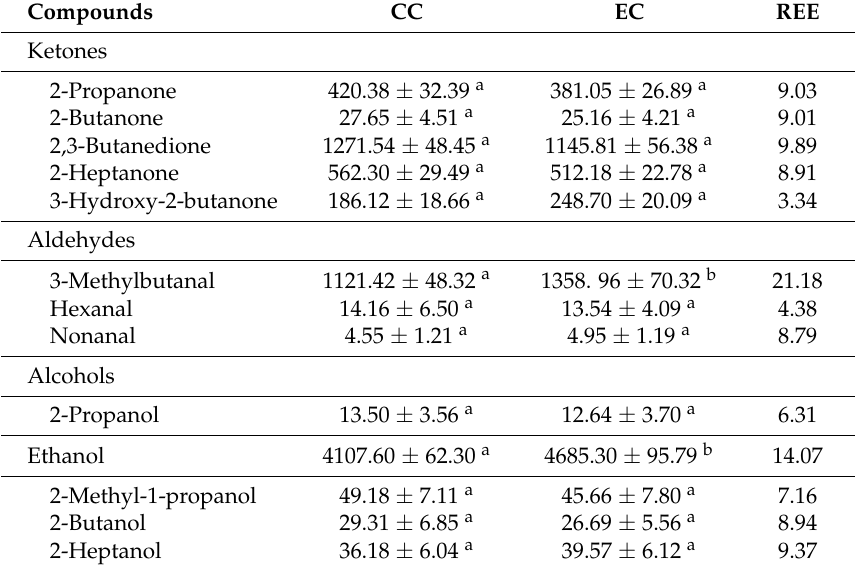
Table 5. Volatile compounds (ppm) of the control and the experimental Manchego cheese by the effect of the β